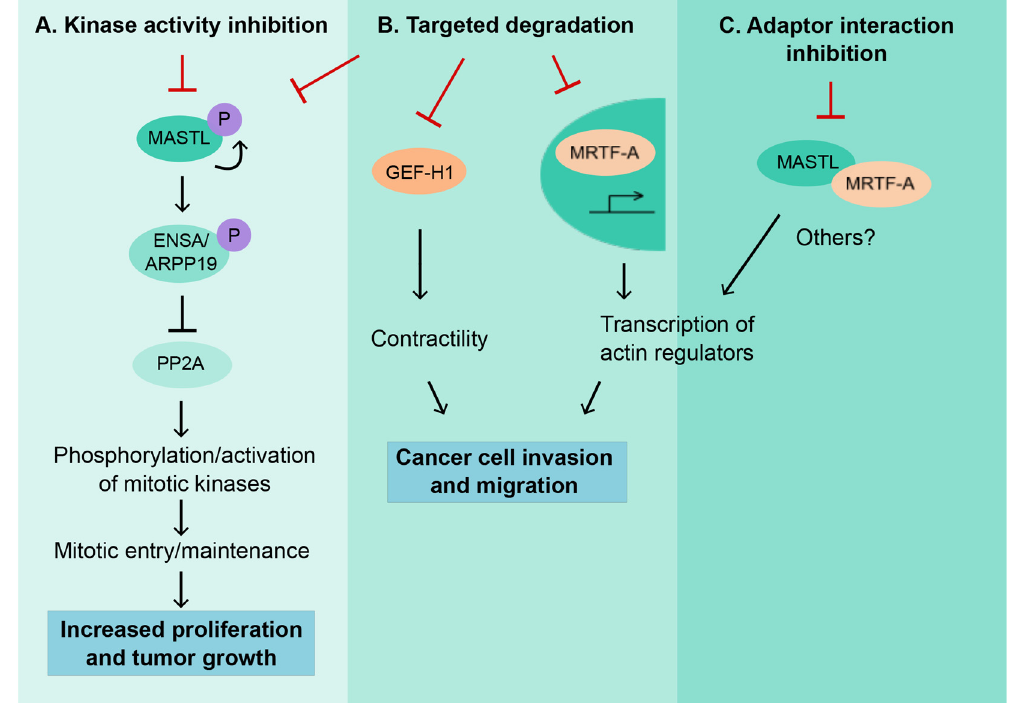
Figure 4. Schematic representation of the possible approaches for MASTL therapeutic targeting and the expected biological outcomes from each strategy. ( A ) Inhibition of MASTL kinase activity could lead to decreased MASTL autophosphorylation [32] and attenuation of the MASTL- Endosulfine alpha (ENSA) / cAMP-regulated phosphoprotein 19 (ARPP19)- Protein phosphatase 2A (PP2A) pathway, cell proliferation, and tumor growth. ( B ) Targeted degradation of MASTL could lead to decreased cancer cell invasion and metastasis via reduced Rho guanine nucleotide exchange factor 2 (GEF-H1) expression and myocardin related transcription factor A (MRTF-A) activity. ( C ) Inhibition of the interaction between MASTL and MRTF-A could lead to decreased MRTF-A activity, and, thus, reduced cancer cell motility.